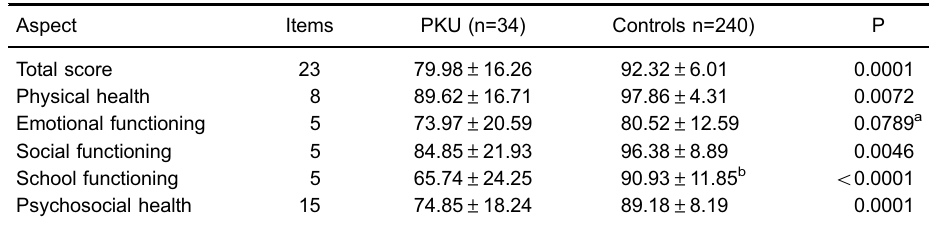
Table 2. Parent-proxy scores for PedsQL 4.0 generic core scales of Brazilian early-treated phenylketonuria (PKU) pediatric patients.